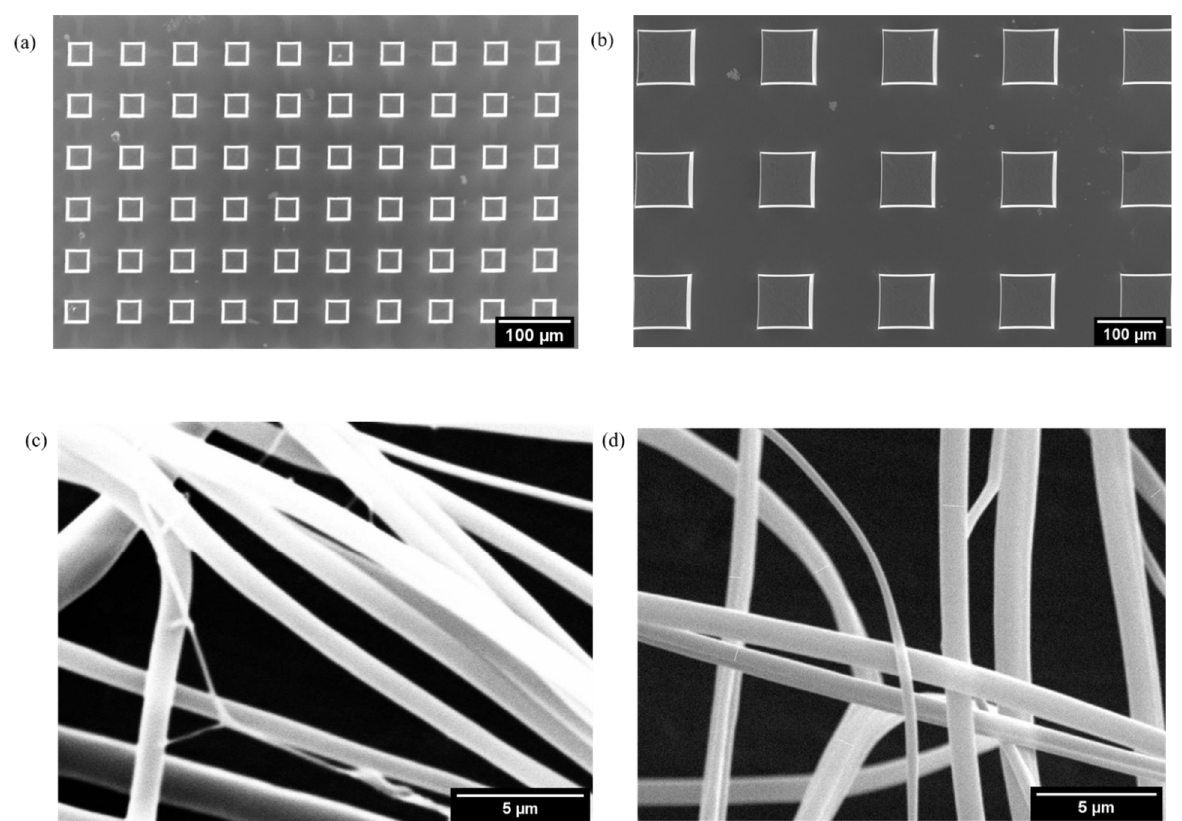
Figure 3. ( a,b ) Top view SEM images of the micro-cuboid structured PUAA-ADH films obtained Figure 3. ( a , b ) Top view SEM images of the micro-cuboid structured PUAA-ADH films obtained with a square shaped mold of ( a ) 40 µm size and of ( b ) 100 µm size and ( c,d ) SEM images of with a square shaped mold of ( a ) 40 µ m size and of ( b ) 100 µ m size and ( c , d ) SEM images of CS/PEO CS/PEO nanofibers produced using ( c ) 20 µL/min, 20 kV & 15 cm and ( d ) 20 µL/min, 25 kV & 15 nanofibers produced using ( c ) 20 µ L/min, 20 kV & 15 cm and ( d ) 20 µ L/min, 25 kV & 15 cm.